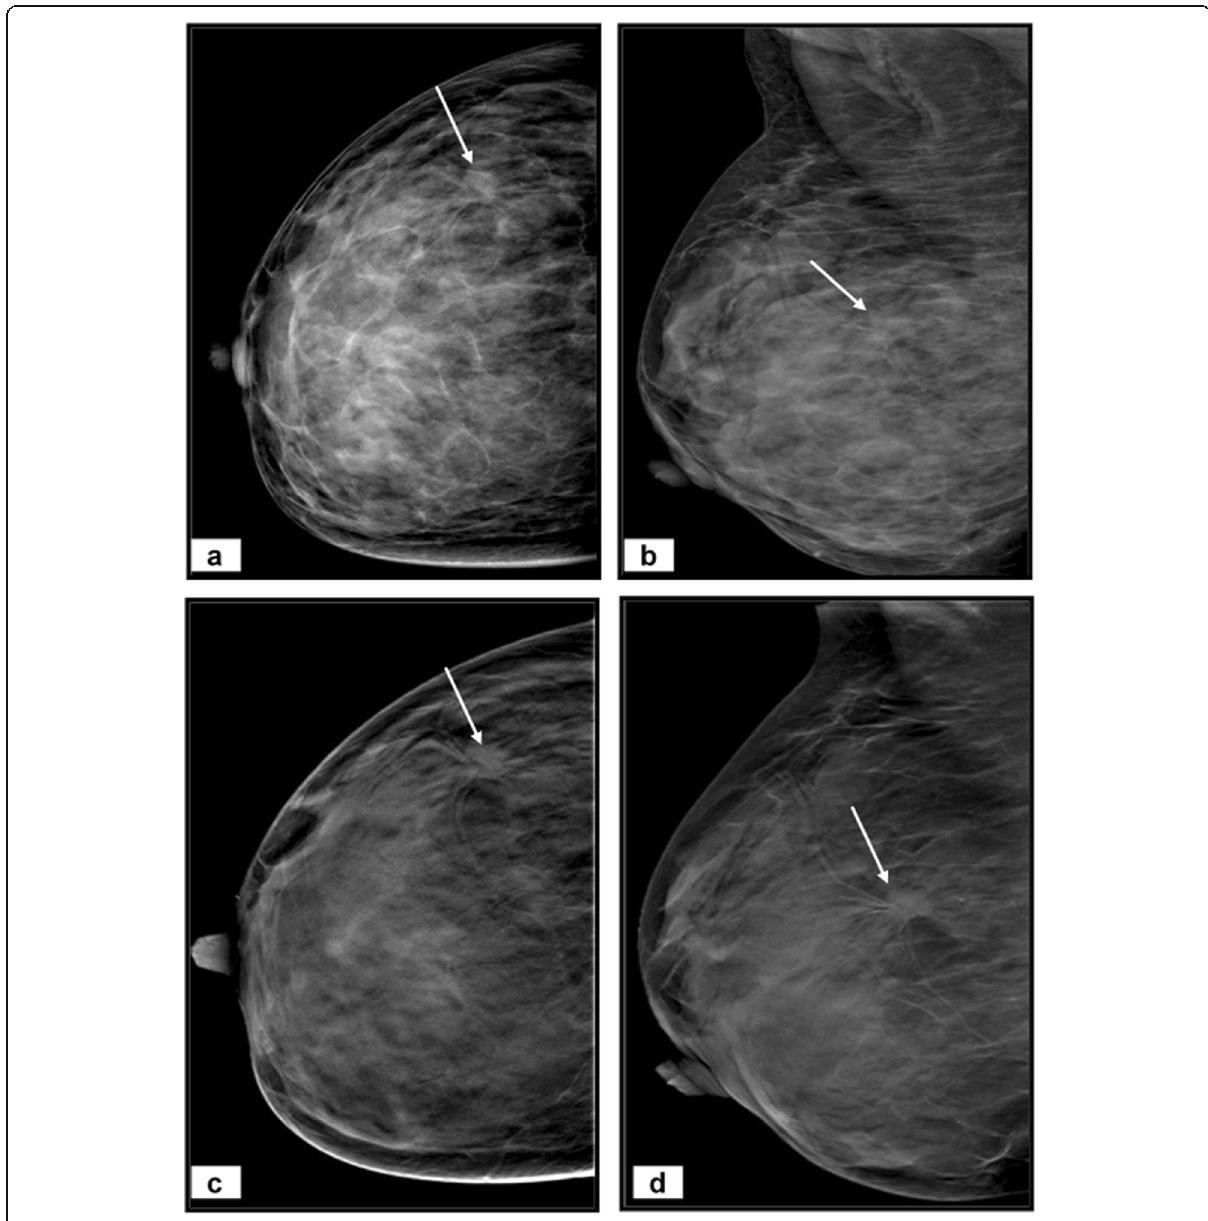
Fig. 3 A 35-year-old woman complains of a right breast lump. a Craniocaudal and ( b ) mediolateral oblique DM images of right breast reveal extremely dense breast (BI-RADS D) with an outer central area of architectural distortion (arrows). No spiculated masses or microcalcifications. c Craniocaudal and ( d ) mediolateral oblique DBT images show a definite lesion with spiculated margins and measures 27 × 25 mm (arrows). The lesion was categorized as BI-RADS 4a by DM and BI-RADS 4c by DBT. Histopathology after surgery revealed invasive lobular